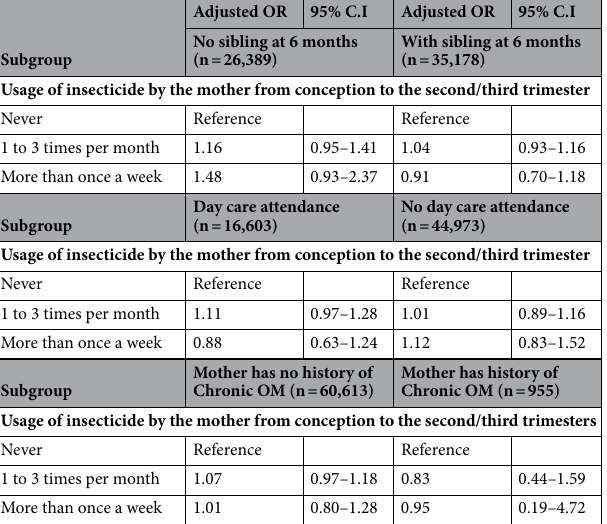
Table 5. Association between the history of otitis media in the first year in children and maternal insecticide use from conception to the second/third trimester in subgroup analysis. OR odds ratio, 95% C.I. 95% confidence interval, OM otitis media. There were three subgroups, including living with siblings at 6 months, daycare attendance, and maternal history of chronic otitis media. These analyses were adjusted for sex, exclusive breastfeeding for the first 6 months, maternal age, gestational age, birth weight, living with siblings at 6 months, daycare attendance, maternal history of chronic otitis media, Hib vaccination, pneumococcal vaccination, maternal and paternal smoking history, exposure to secondhand smoke, diagnosis of trisomy 21, fertility treatment, family member’s smoking and maternal occupational category.